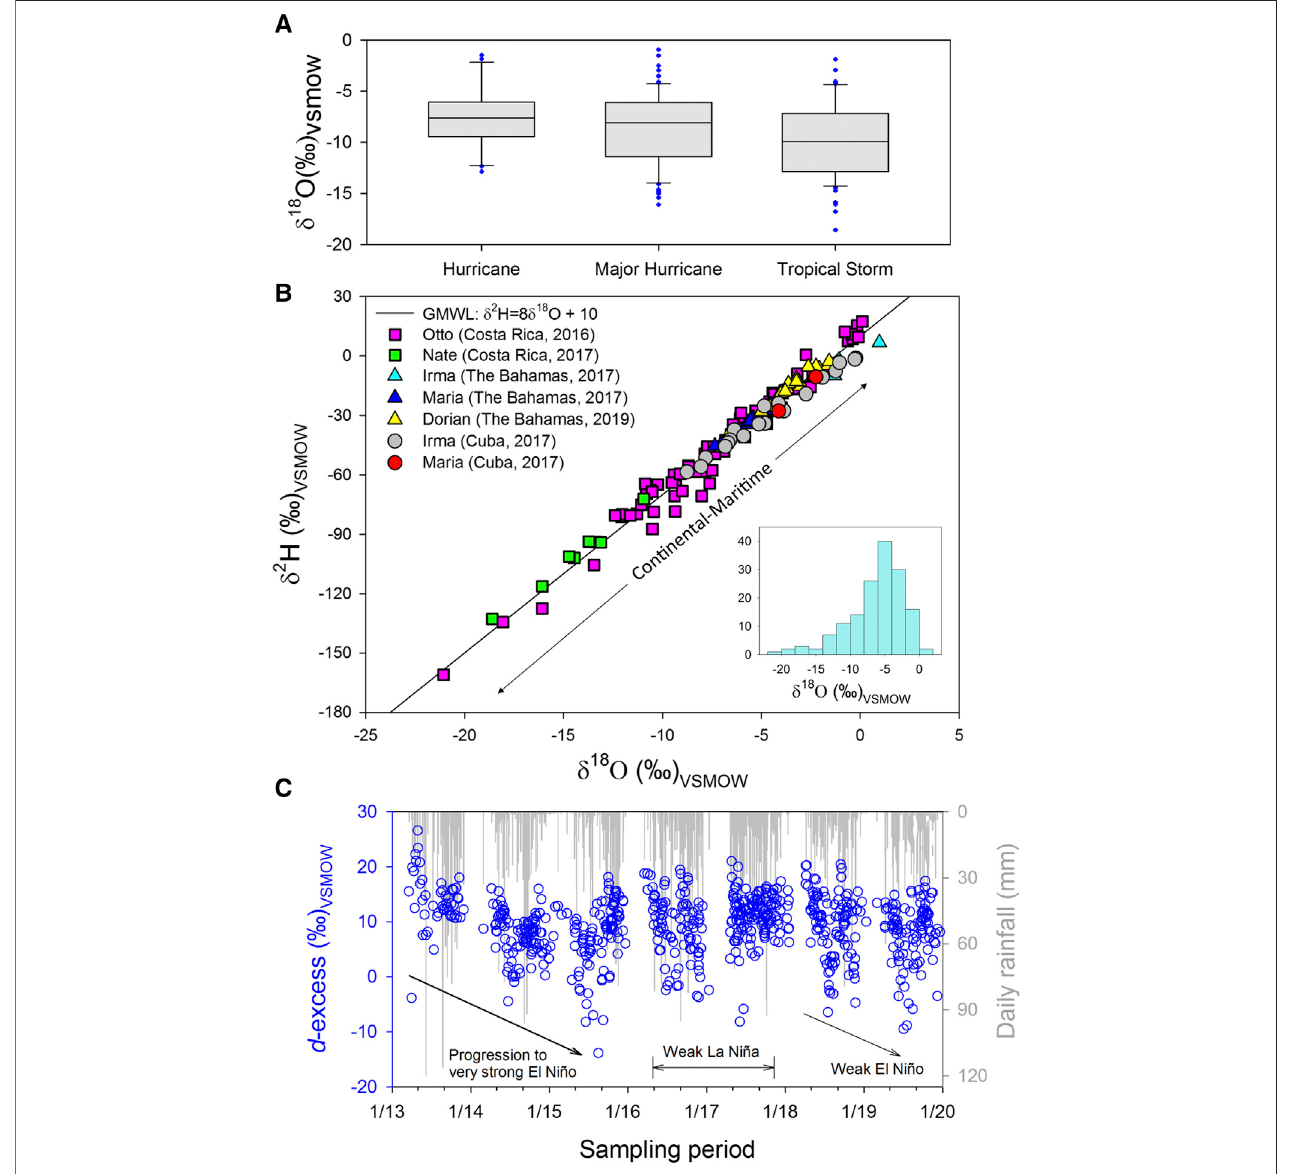
FIGURE8| TropicalcyclonesandENSOisotopevariability.Boxplotsinpanel (A) denotethein fl uenceofhurricanes(Categories1 – 3),majorhurricanes(Categories 4 – 5), and tropical storms (TS). (B) Dual isotope diagram showing the evolution of TCs (color and symbol coded) within the Caribbean Sea and Atlantic Ocean basins. Enriched compositionswerepresented inmaritimelandfallsandpassages, whereasTC-continentallandinteractionisrepresentedbymoredepletedcompositions.The insetshowsaright-skewedhistogramforall δ 18 Ocompositions(WelshandSánchez-Murilloetal.,2020).Timeseriesinpanel (C) shows d -excessandrainfall(mm/ day) changes including ENSO ’ s neutral, warm, and cold phases (2013 – 2019). Figure adapted using data from Sánchez-Murillo et al. (2019a) and Welsh and Sánchez- Murillo (2020).